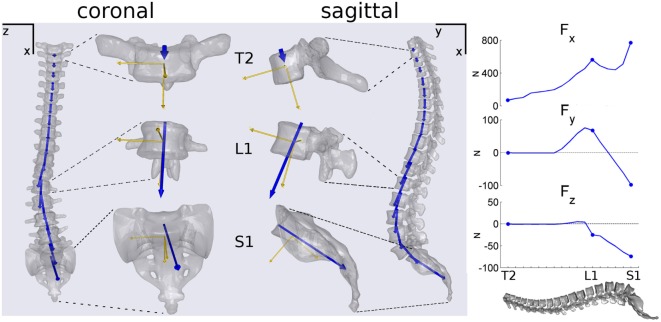
Example illustrating coronal and sagittal projections of the spine and of disk joint load vectors F (in blue) calculated for a subject. T2, L1, and S1 vertebrae are showed magnified depicting in addition the vertebral local reference systems (in yellow). In the right panel, progression of the F components in global coordinates {x,y,z} proceeding along spine from T2 to S1.